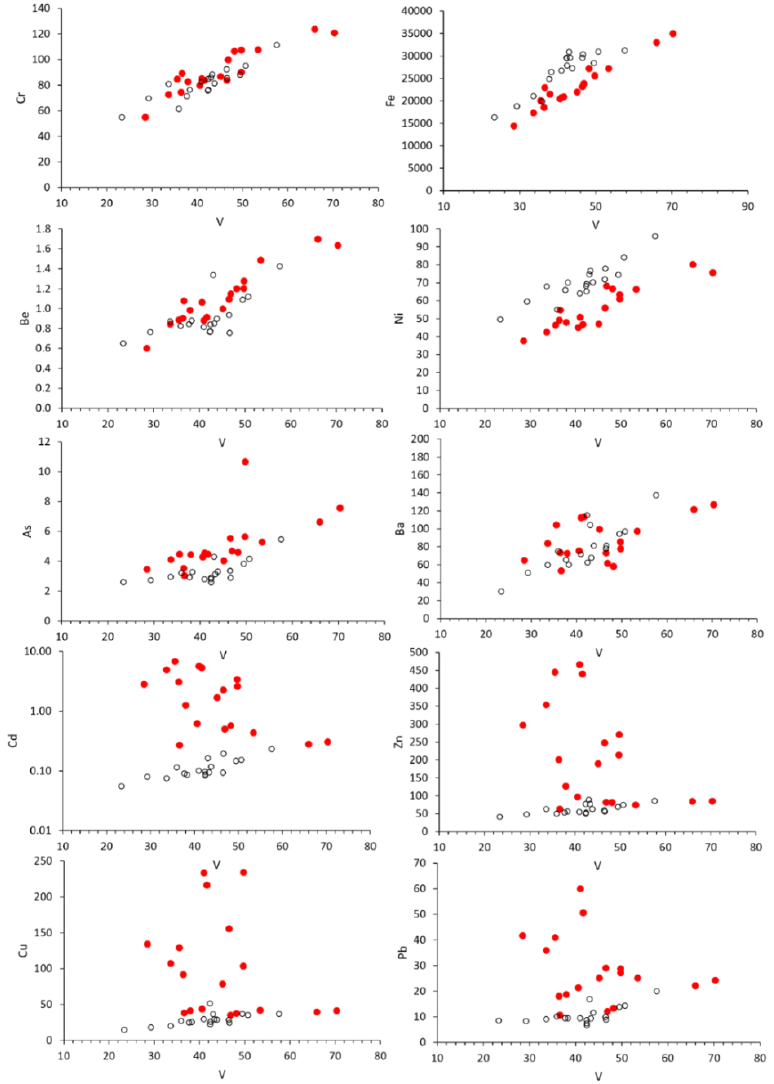
Figure 5. Cr, Fe, Be, Ba, Ni, As, Cu, Zn, Cd and Pb concentrations (mg/kg) vs. V (mg/kg) in Fornaci di Barga soils (filled circles) and Pontecosi lake sediments (open circles).